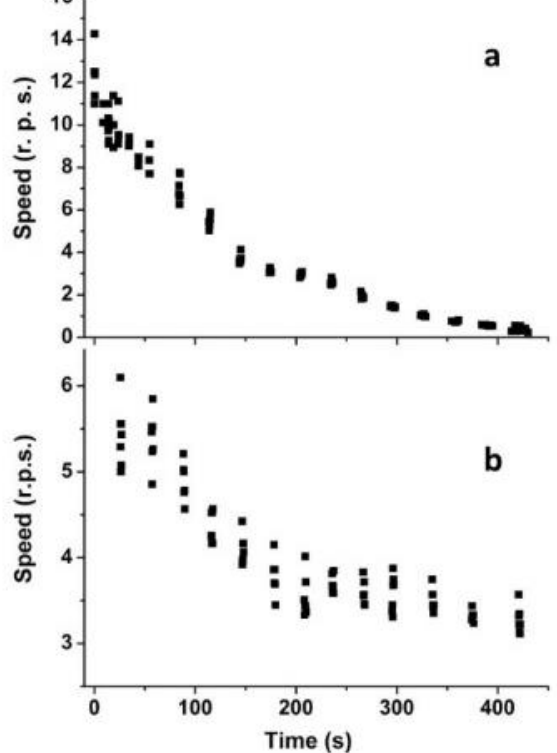
Figure 2. Time dependence of the speed (r.p.s.—rotation per second) of uniform rotation for liquid marbles with different weights: ( a ) 2.5 mg; ( b ) 59.5 mg.